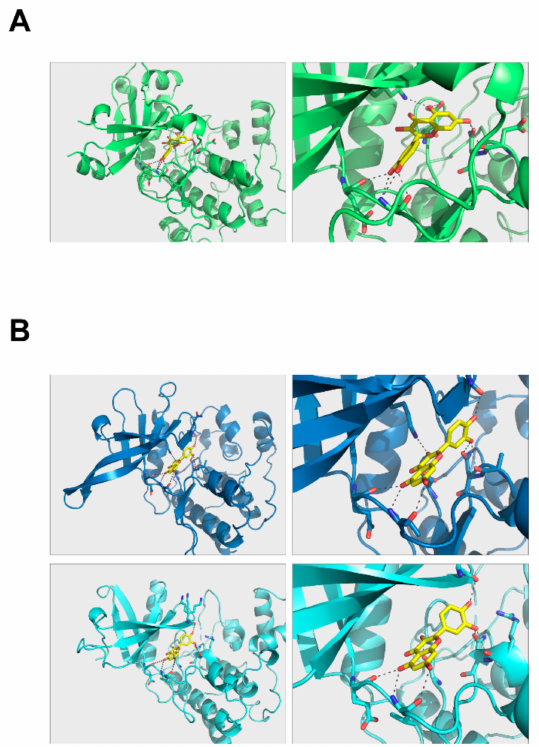
Figure 6. Quercetin complex structure models. ( A ) PKC δ and ( B ) JAK2 protein kinase 1 (upper panel), JAK2 protein kinase 2 (lower panel). Autodock scores for PKC δ , JAK2-PK1, and JAK2-PK2 = − 8.9, − 8.9, and − 9.3 kcal / mol,